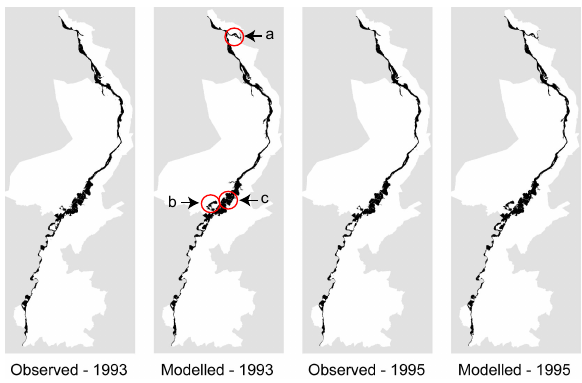
Fig. 5. Detailed view of the inundation extent maps for 1993 (ob- served and modelled) for the three locations shown in Fig. 4. The model did not perform well at locations a (confluence of the Niers and the Meuse rivers) and b (the lake known as the Lange Vli- eter, completed post-1995). Location c shows an example of a river stretch where the model performed